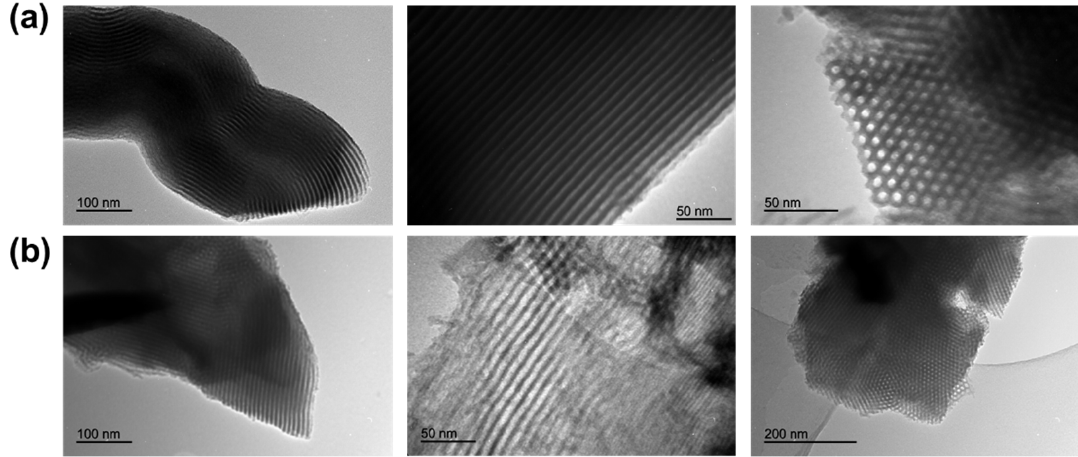
Figure 6. TEM images of EthanePMO ( a ) and EthanePMO@NCOFeFe ( b ).